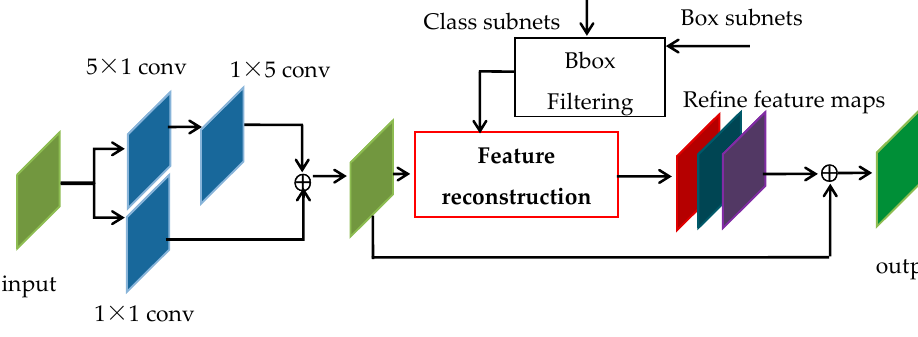
Figure 5. FRM structure.